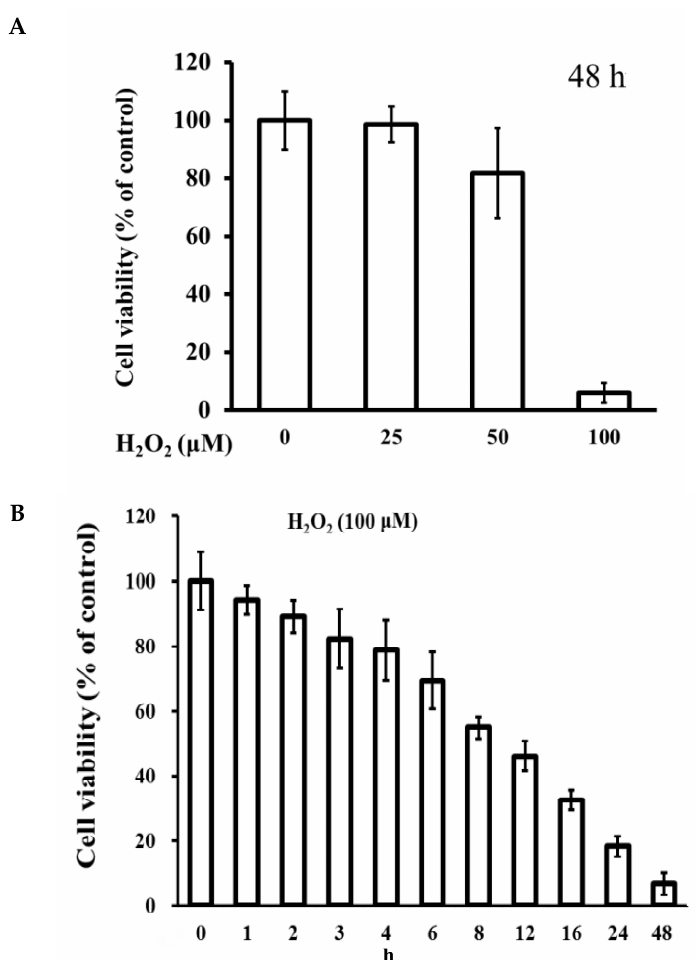
Figure 1. Cytotoxic effect of H 2 O 2 on adult retinal pigment epithelium-19 (ARPE-19) cells. Cell viability of ARPE-19 cells, following different concentrations of H 2 O 2 exposure, measured by trypan blue exclusion test. Dose ( A ); and ( B ) time effect of H 2 O 2 (100 µ M) on ARPE-19 cells. Results are expressed as percentages of control, and each value represents the mean ± SD of three independent experiments.